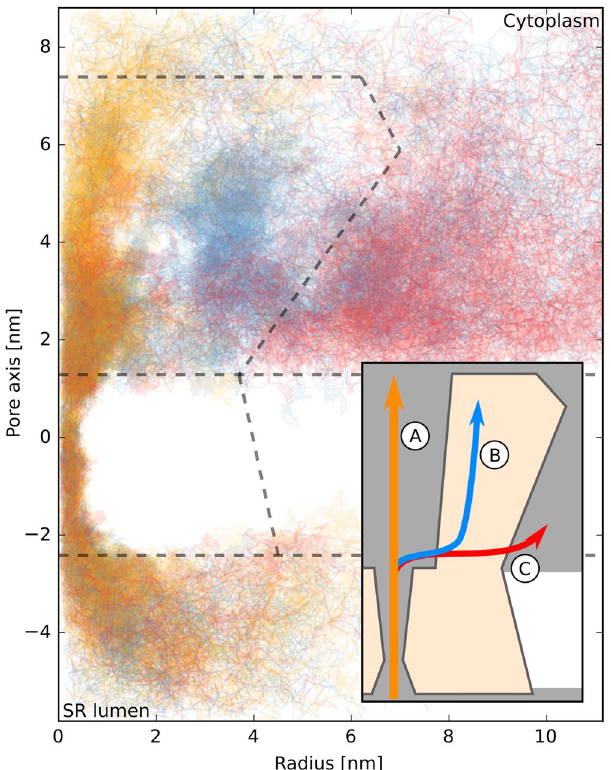
Figure 5. Ion trajectories of the simulation at 0.3 V are visualized by plotting axial coordinate against the distance to the pore axis (radius). Each trajectory is classified and color coded based on the path taken: Ⓐ , Ⓑ , Ⓒ . The outline of the membrane and the receptor are shown by dashed gray lines for orientation. The inset shows a schematic sketch of the 3 modes of exiting the receptor with their respective